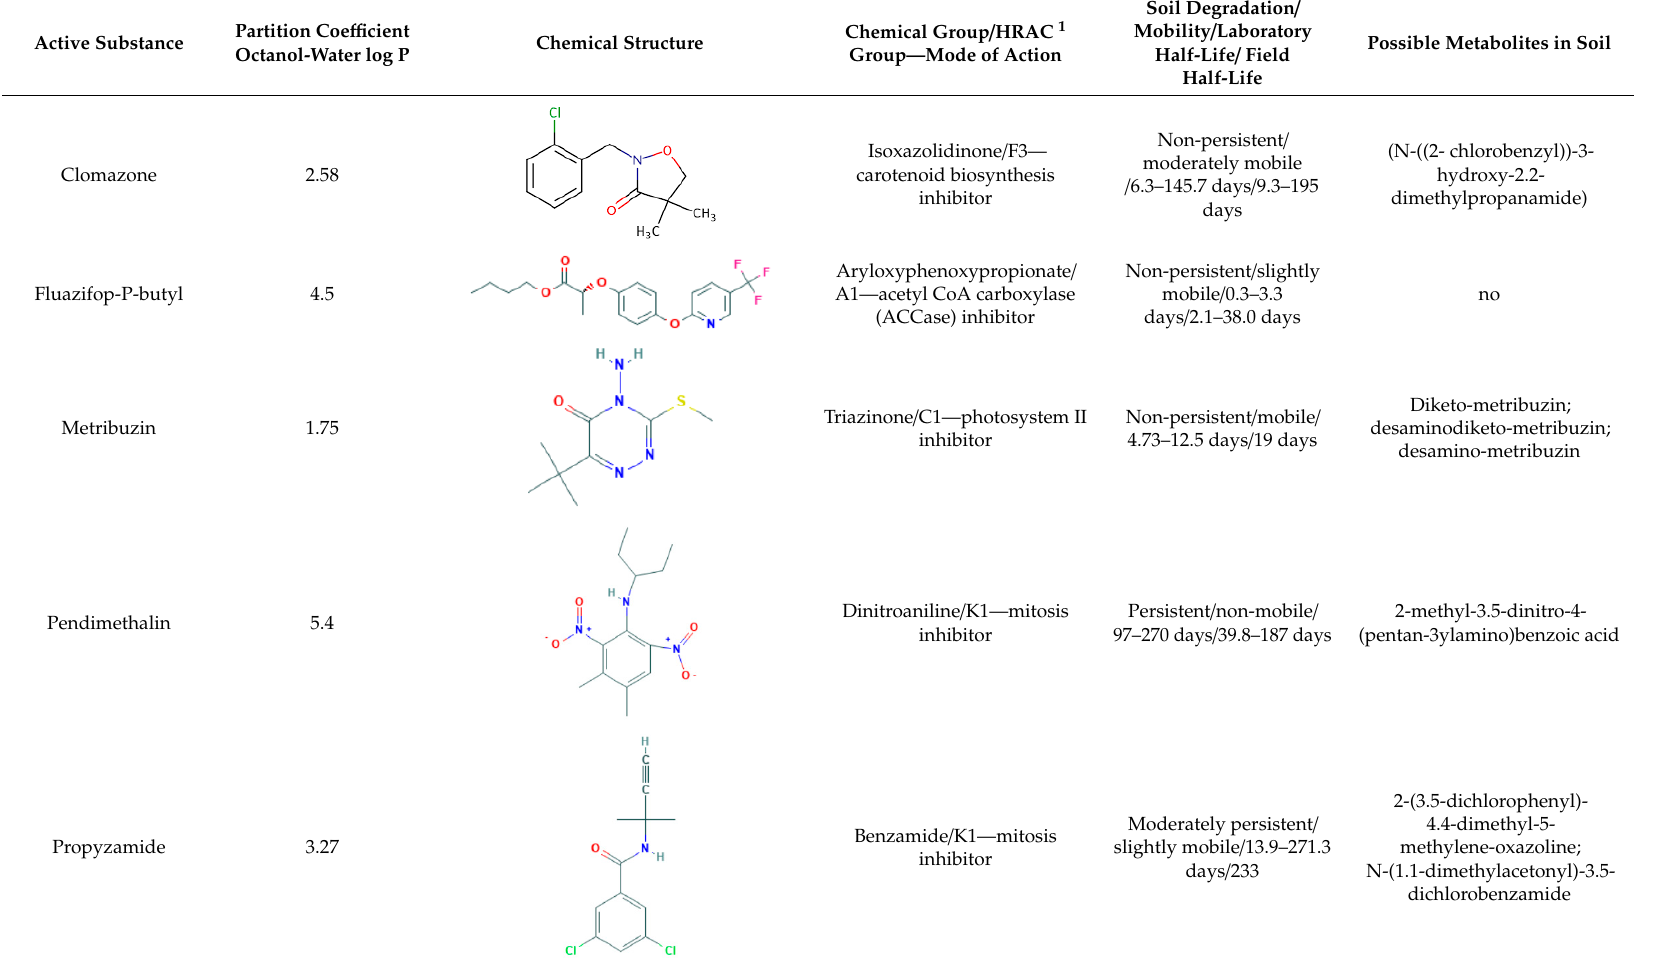
Table 1. Active substances of studied herbicides and their properties [23,24].